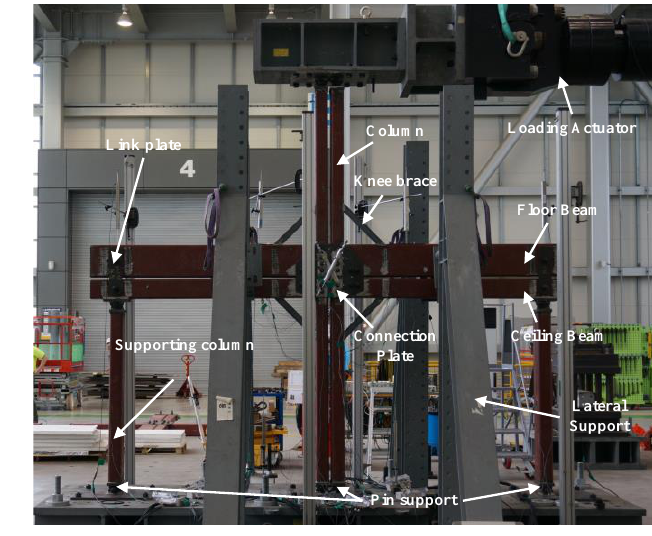
Figure 8. Specimen setting.